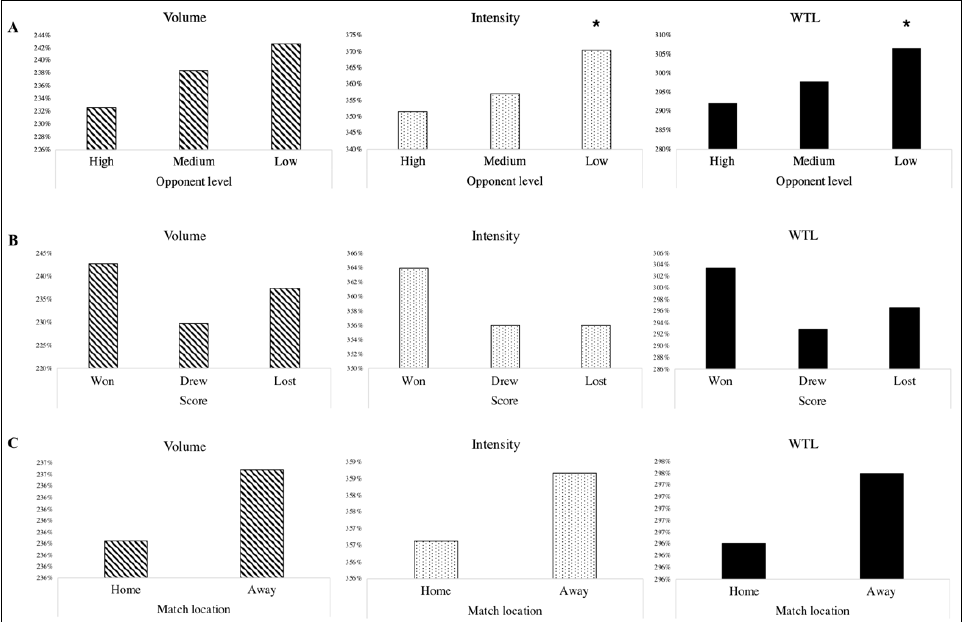
Figure 3. Volume, intensity and WTL according to ( A ) opposition’s level, ( B ) final score and ( C ) match location. * Significant differences between low and high opponent level according to the intensity and WTL ( p < 0.05).